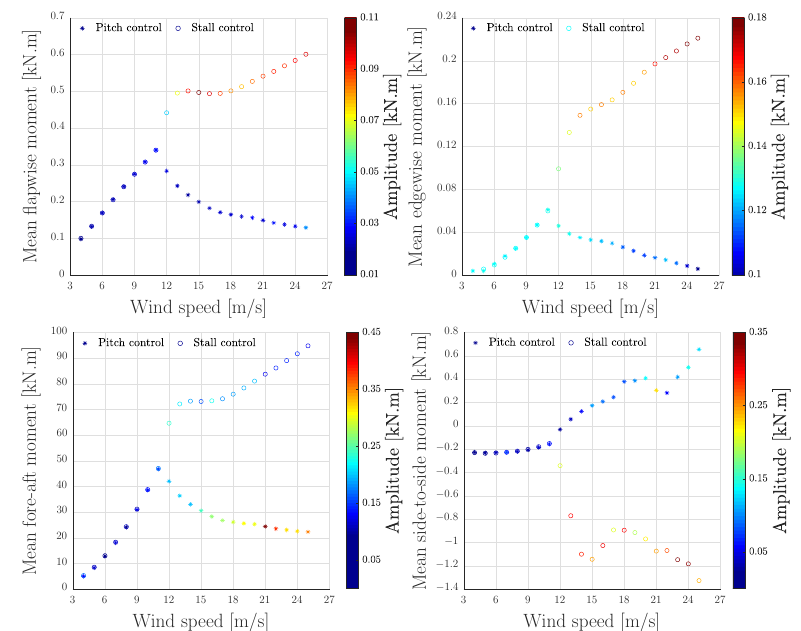
Figure 13. Comparison of the fatigue loads on the structure of the SWRT wind turbine operating with pitch-to-stall and pitch-to-feather control in the whole wind speed range.